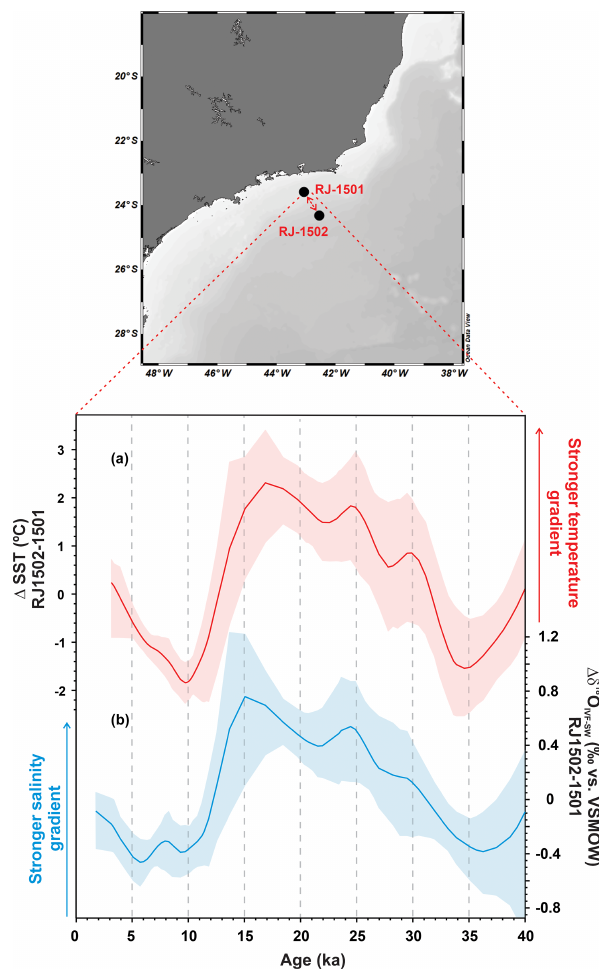
Figure 6. Sea surface temperature and salinity gradient formed in the area between the marine sediment cores RJ-1501 and RJ-1502 (map in the uppermost panel) during the Last Glacial Maximum and early deglaciation interval. Records were placed on a common timescale (RJ-1501), and the means around zero were subtracted (cid:48) (RJ-1502 minus RJ-1501) to produce alkenone (U K )-derived sea 37 surface temperature (SST) and (cid:49)δ -ice-volume free seawater oxy- gen isotope ( (cid:49)δ 18 O IVF − SW ). The records were bootstrapped using the Acycle software with a 10% window (Li et al., 2019) and pre- sented with the 2.5th and 97.5th percentiles (red and blue shaded (cid:48) areas). (a) (cid:49)δ U K -derived SST. (b) (cid:49)δ 18 O IVF − SW 37